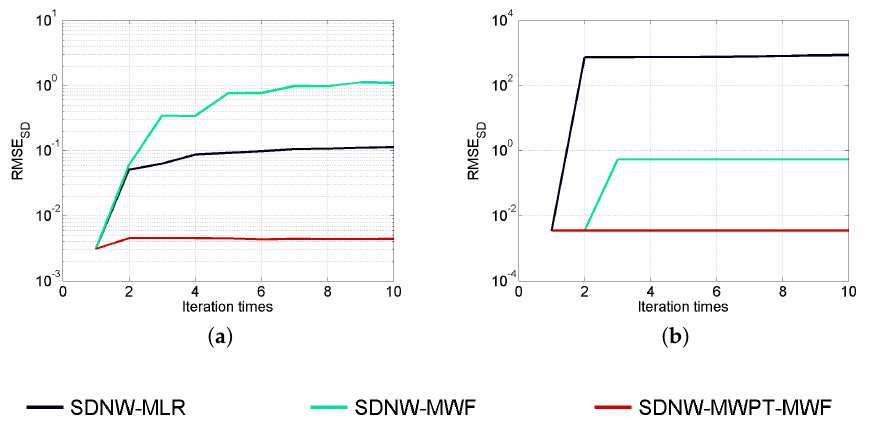
Figure 4. Evolution of RMSE SD with iteration times according to different values of SNR INPUT :